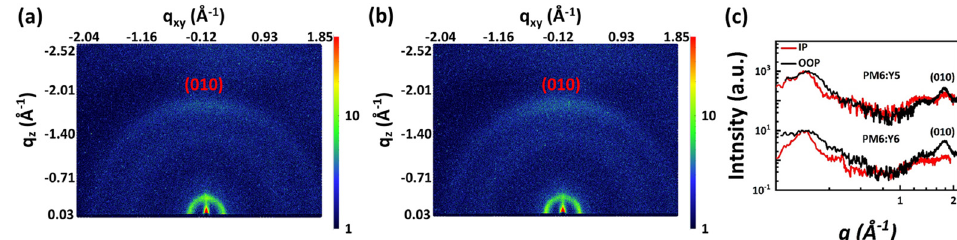
Figure 3. Two − dimensional GIWAXS patterns of the ( a ) PM6:Y5 and ( b ) PM6:Y6 blend films and ( c ) the diagram of scattering intensity for the PM6:Y5 and PM6:Y6 blend films. Table 2. Details of parameters of the (010) peak for the GIWAXS measurement. Active Layer